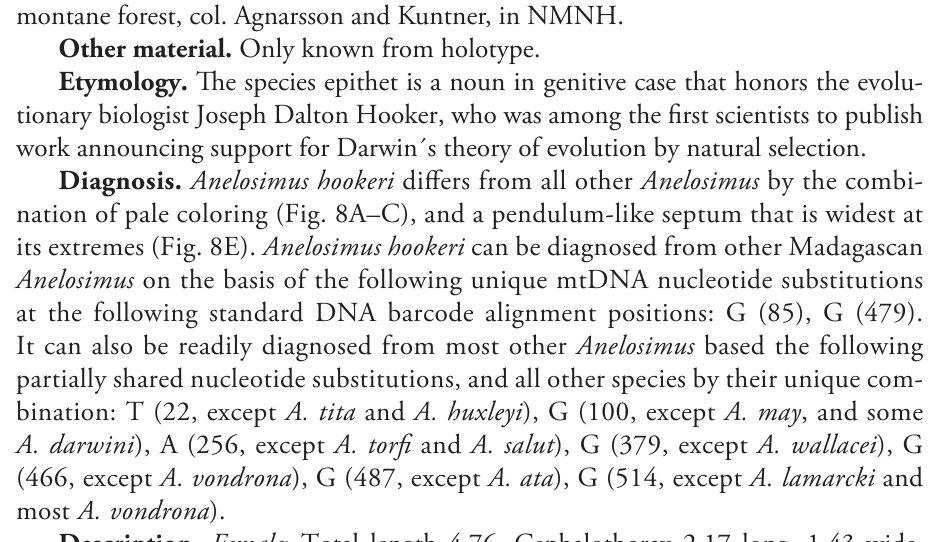
Type material. Holotype female from Ambohitantely Special Reserve (18.161°S, 47.302°E), 1500 m alt, Analamanga region, Ankazobe district, Madagascar, 28.iv.2008, montane forest, col. Agnarsson and Kuntner, in NMNH. Other material. Only known from